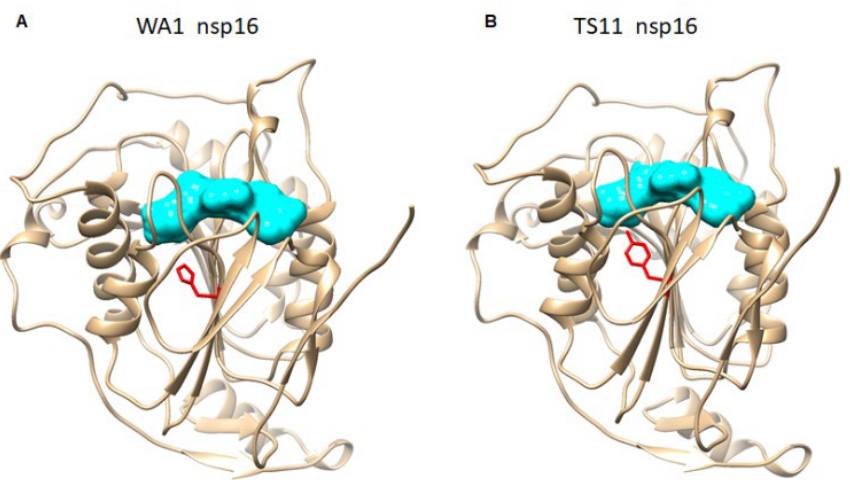
Figure 6. Three-dimensional structural analyses of the nsp16 proteins of SARS-CoV-2 WA1 ( A ) and SARS-CoV-2 TS11 ( B ). They were modeled based on the structure of nsp16 of SARS-CoV-2 WA1 from the Protein Data Bank (PDB accession number 6WKS). S-adenosyl methionine is in Cyan. Tyrosine (TYR); Histidine [18].